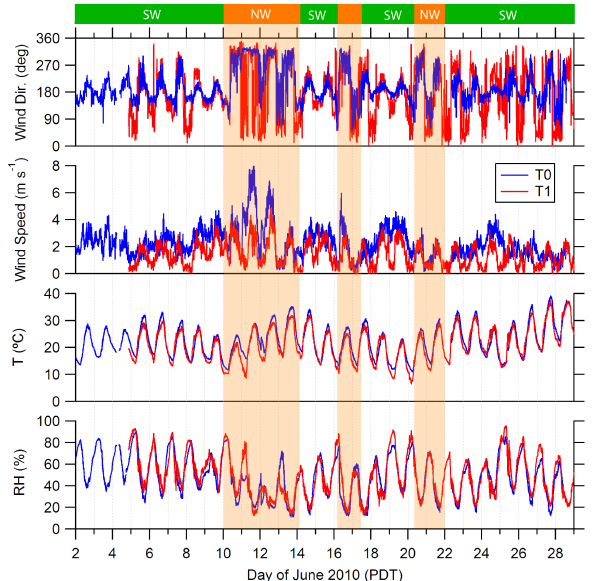
Fig. 5. Time series of standard meteorological variables at the T0 and T1 ground sites. The green-orange bar at the top indicates peri- ods during which the synoptic wind was either southwesterly (SW) or northwesterly (NW). Semi-transparent orange shading for the NW flow periods is also shown over all the plots.